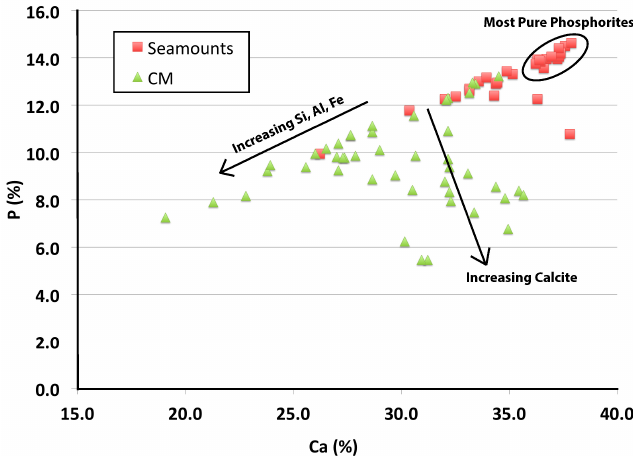
Figure 3. Scatter plot of phosphorus versus calcium for seamount and continental margin phosphorite deposits analyzed here. Arrows show deviations from the carbonate fluorapatite end member (most pure phosphorite) with increasing calcite and detrital/authigenic (Si, Al, and Fe) contents.